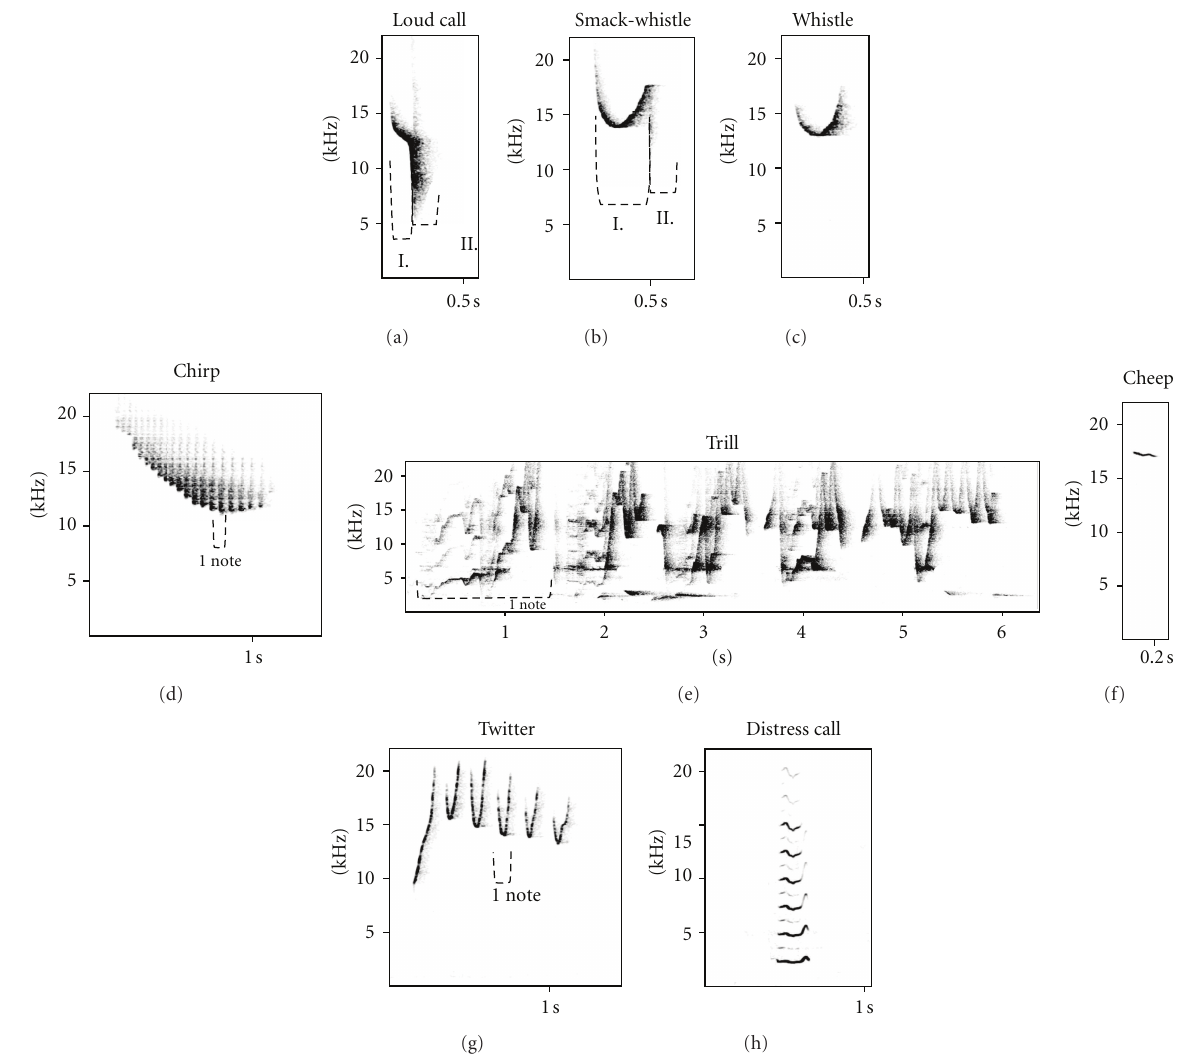
Figure 2: Spectrograms of eight call types reported in the Philippine tarsier (a–h). In loud call (a) and smack-whistle (b), the two parts are labeled I. whistle part, II. smack part, in chirp (d), trill (e), and twitter (g) the note is labelled, other calls are single-note